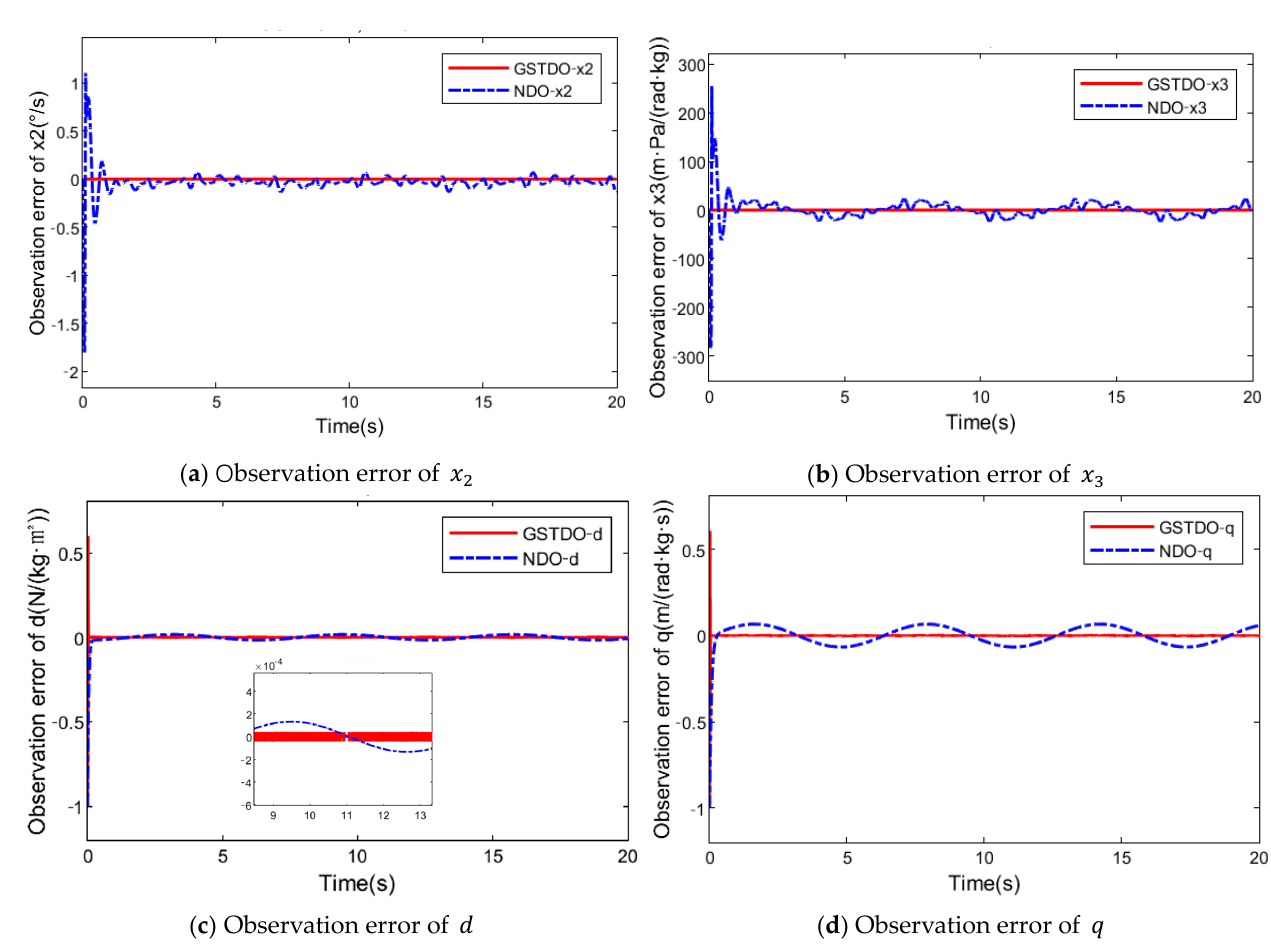
Figure 7. Comparison of the observation error of GSTDO and NDO in Experiment 1.